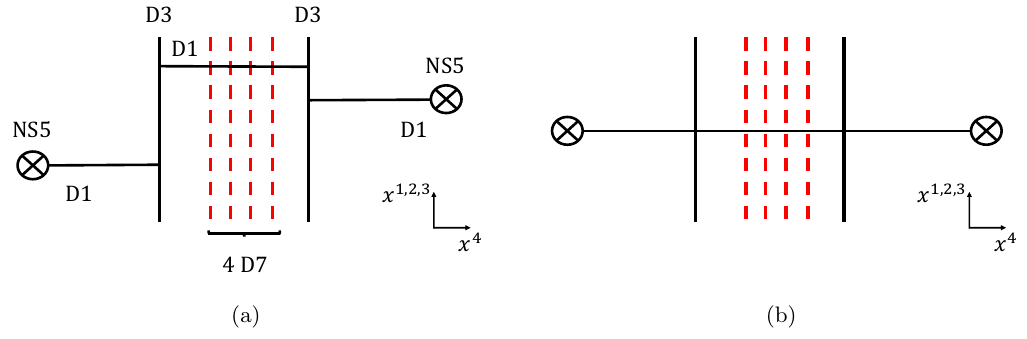
Figure 2 . (a) The brane con(cid:12)guration where a (cid:12)nite D1-brane is added to the con(cid:12)guration in (cid:12)gure 1(b). (b) Tuning the position of the D1-brane and two NS5-branes in (cid:12)gure 2(a) so that they are at the same point in the ( x 1 ; x 2 ; x 3 )-space. The magnetic charge of the line operator is completely screened and the con(cid:12)guration describes the v = 0 sector.